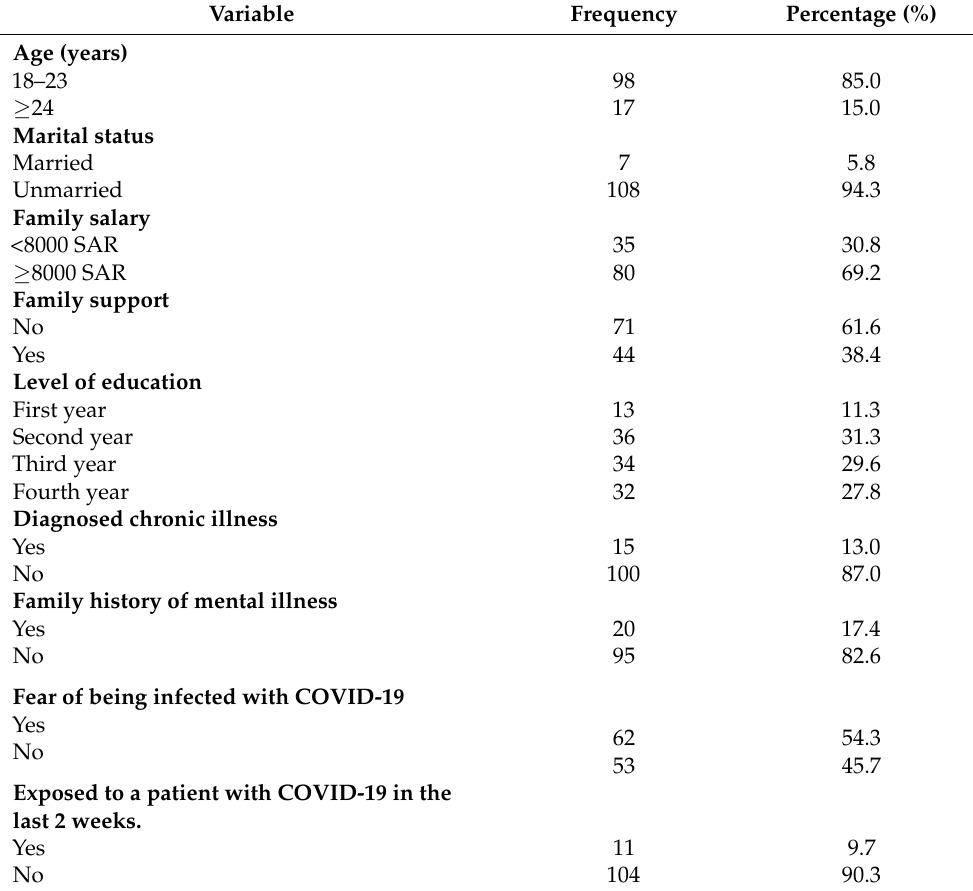
Table 1. Description of sociodemographic characteristics ( N =